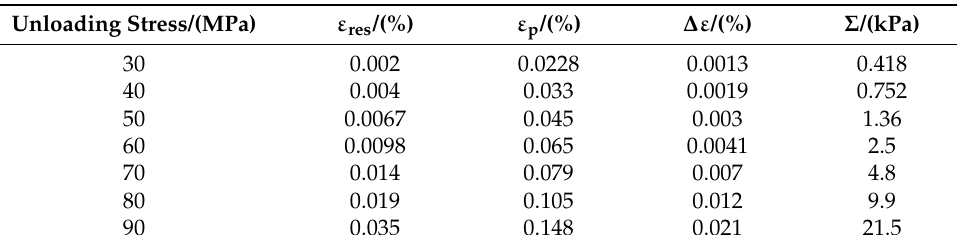
Table 6. Cyclic loading/unloading damage parameters of Type 4 3D needle-punched C/SiC composite.